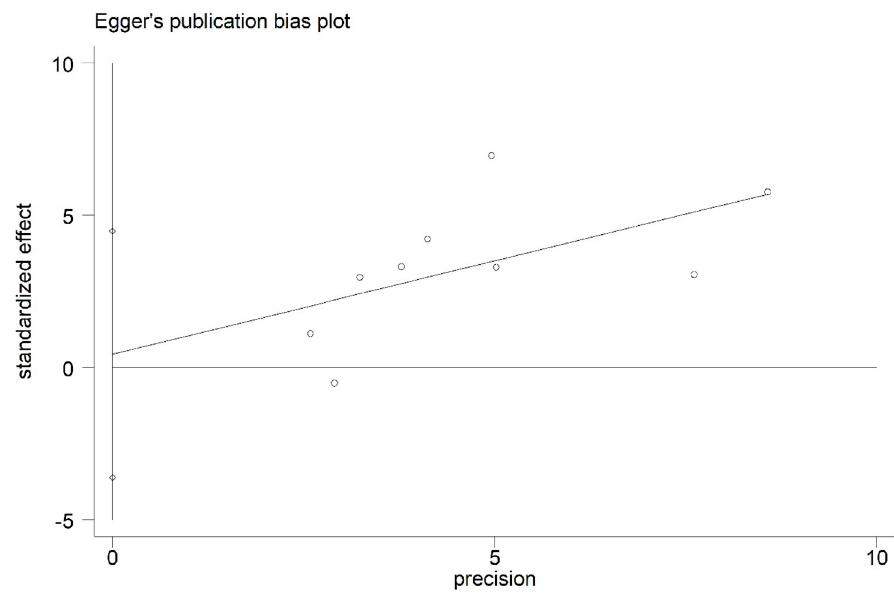
Fig 11. Egger’s publication bias plot for little or no nipple cleaning.